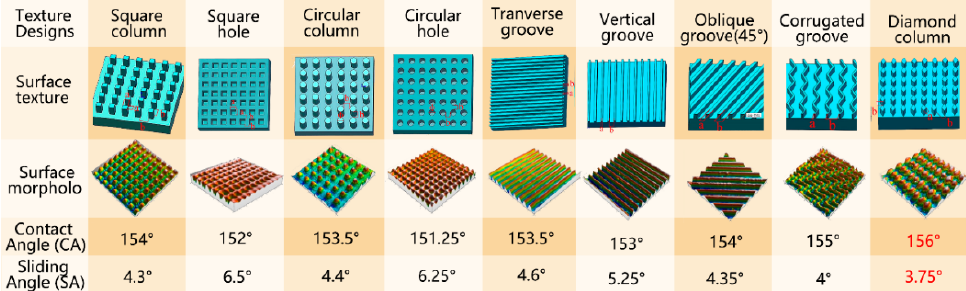
Figure 3. Influence of different laser engraving structures on hydrophobicity of composite insulators.